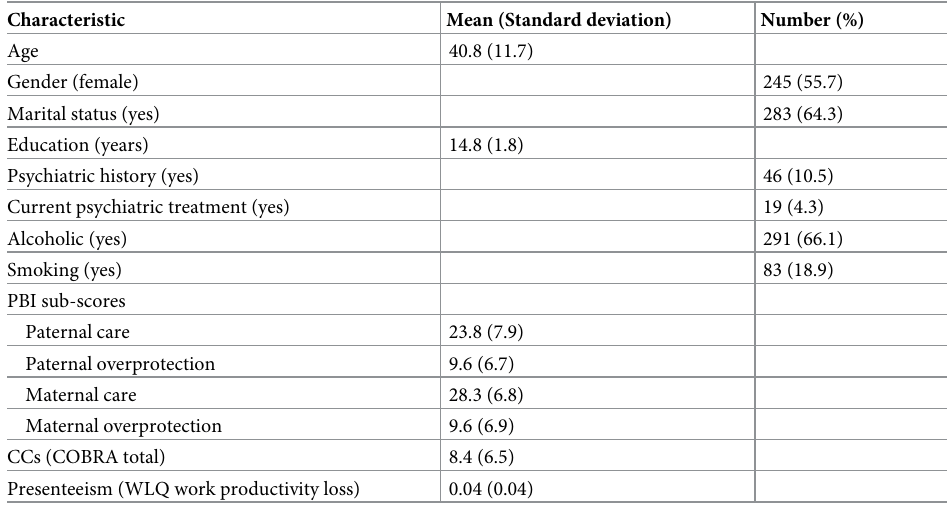
Table 1. Sociodemographic characteristics (N = 440).